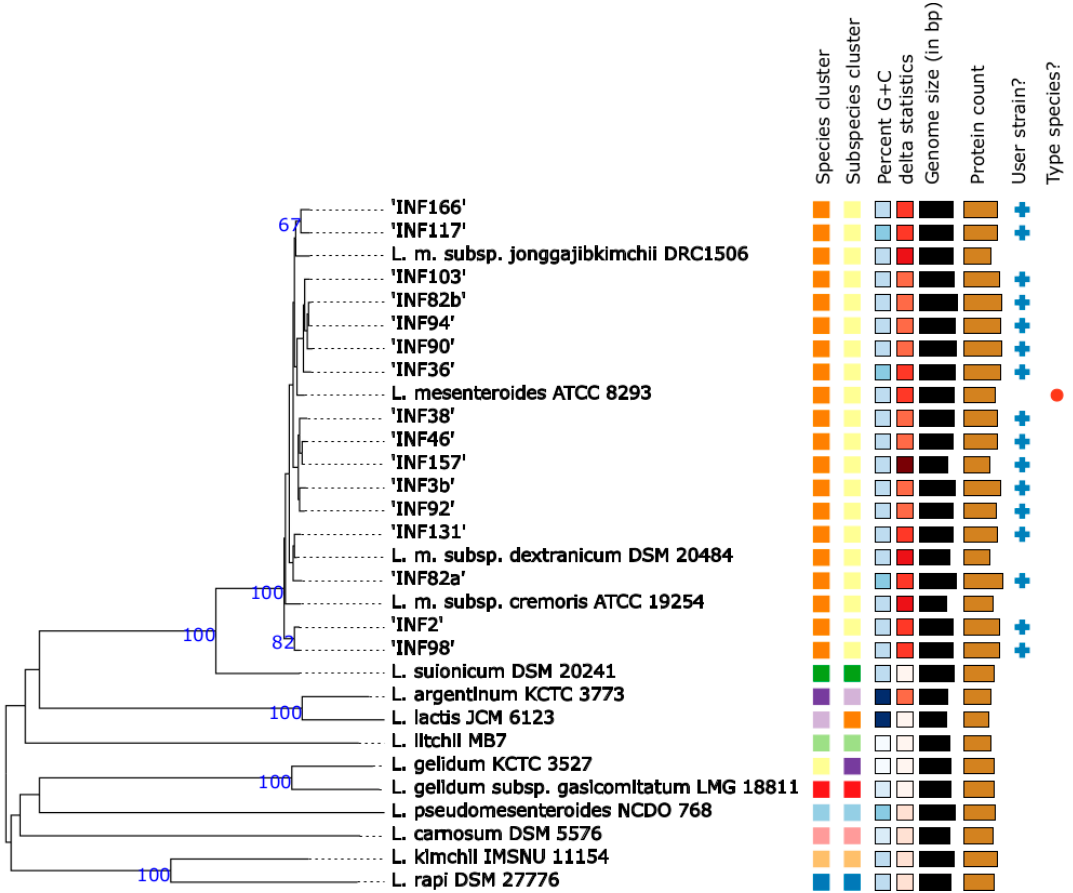
Figure 1. Type Strain Genome Server analysis (TYGS) of all 16 Montenegrin brine cheese isolates and Leuconostoc sp. type strains available from the TYGS database.